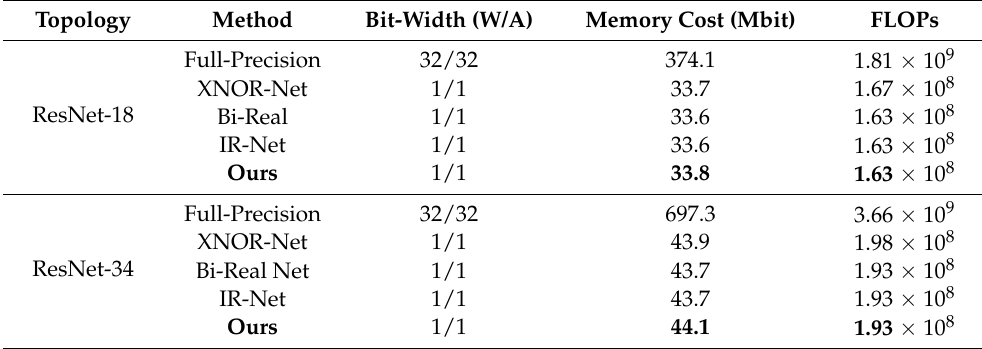
Table 6. Comparison of memory cost and computation complexity with different methods based on ResNet-18 and ResNet-34. The memory cost is represented by the number of bits occupied by the model parameters, and the computational cost is denoted by the floating-point operations within the binary model. The proposed networks are highlighted in